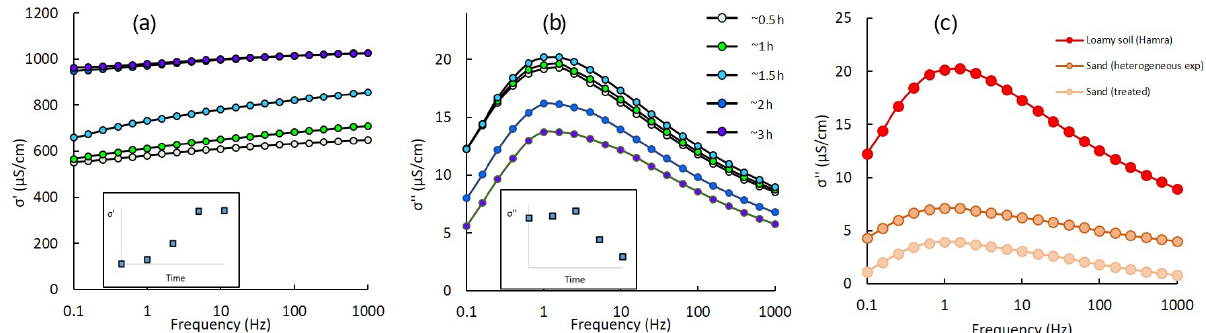
Figure 2. Real (a) and imaginary (b) conductivity between 0.1 and 1000Hz at five different times ( ∼ 0.5, ∼ 1, ∼ 1.5, ∼ 2, ∼ 3h) for the loamy soil. The inserts in (a) and (b) schematically present the dynamics of the real and imaginary conductivity at 1Hz. Panel (c) shows the imaginary conductivity of the three soils used in this work: loamy soil, sand (untreated; used for the heterogeneous experiment) and treated